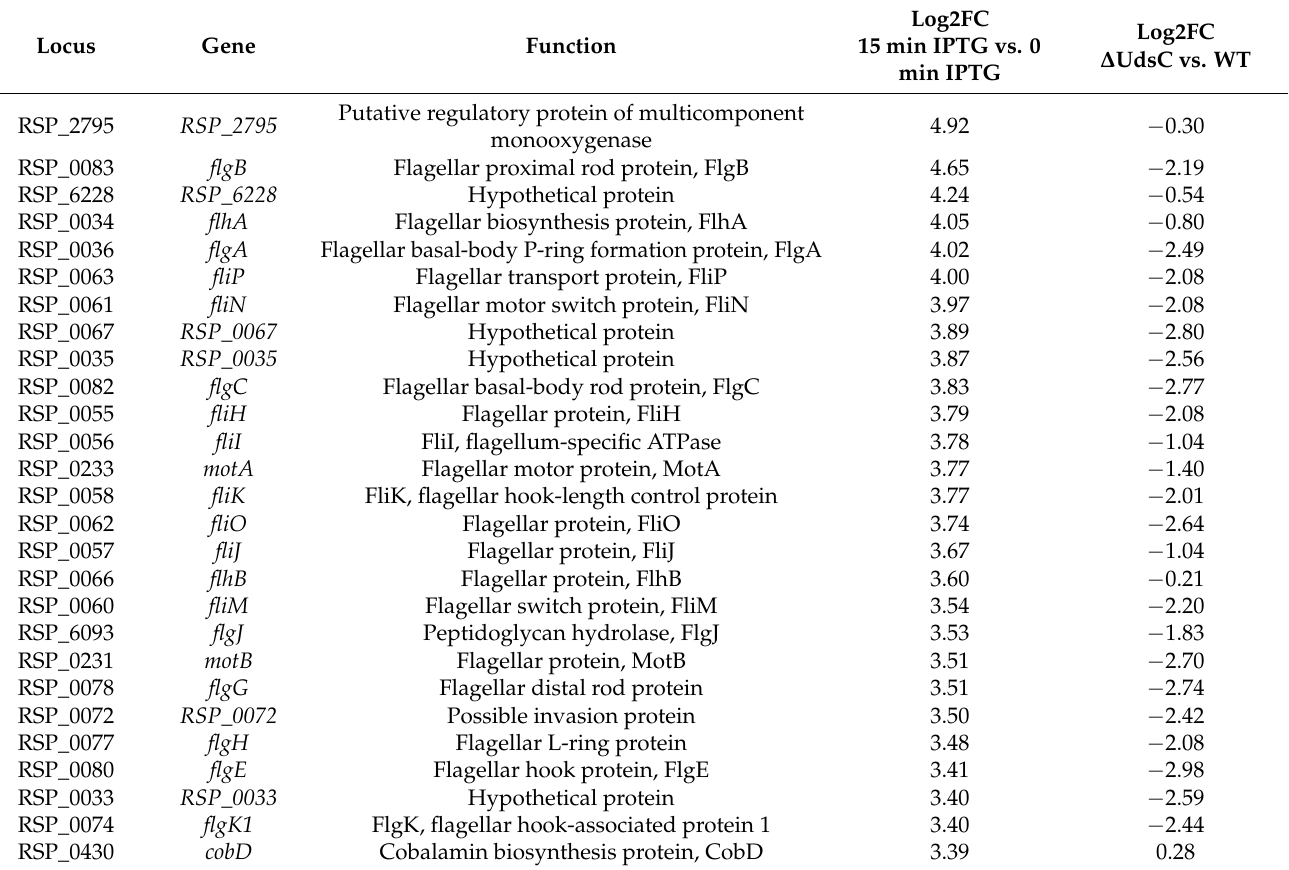
Table 1. Log 2 fold changes (calculated by DEseq2 analysis) in read counts determined by RNAseq within a UdsC-overexpression strain (OE UdsC) after 15 min of IPTG treatment in comparison to the UdsC-overexpression strain without (0 min) IPTG treatment and the UdsC-knockout strain ( ∆ UdsC) in comparison to the wild type (WT). The table shows the top 50 upregulated genes for the UdsC overexpression strain with exposure to IPTG (15 min) versus that without exposure to IPTG (0 min) in the fourth column. Torf and UdsC are marked in